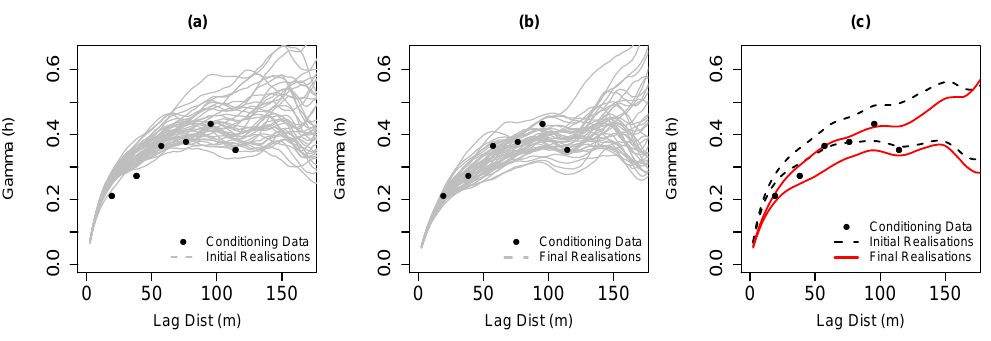
Figure 7. Variograms of the realisations and the experimental variogram of the borehole data: ( a ) Variograms before the optimisation; ( b ) variograms after the optimisation and ( c ) 99.9% confidence interval of the variograms before and after the